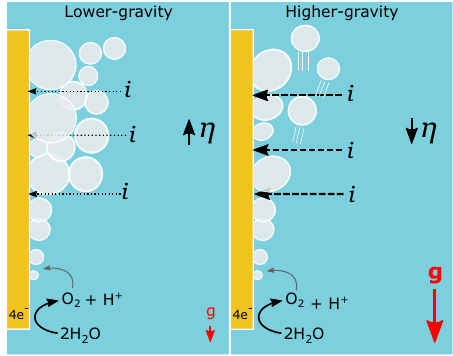
Fig. 1 In fl uence of bubbles on overpotential in different gravity levels. A comparison of a lower-gravity vs. a higher-gravity scenario where electrolytic production of oxygen via the electrolysis of water leads to the nucleation, growth, and coalescence of bubbles at the surface of the electrode. In the lower-gravity case, bubbles will adhere more to the surface, increasing ohmic resistance and increasing overpotential compared to the higher-gravity system, where bubbles will detach more rapidly from the electrode, reducing resistance in the system and lowering overpotential. The gravity-levels have been left arbitrary as this relationship applies to any comparison of different gravity environments. i = current fl ow; g = gravity; η =